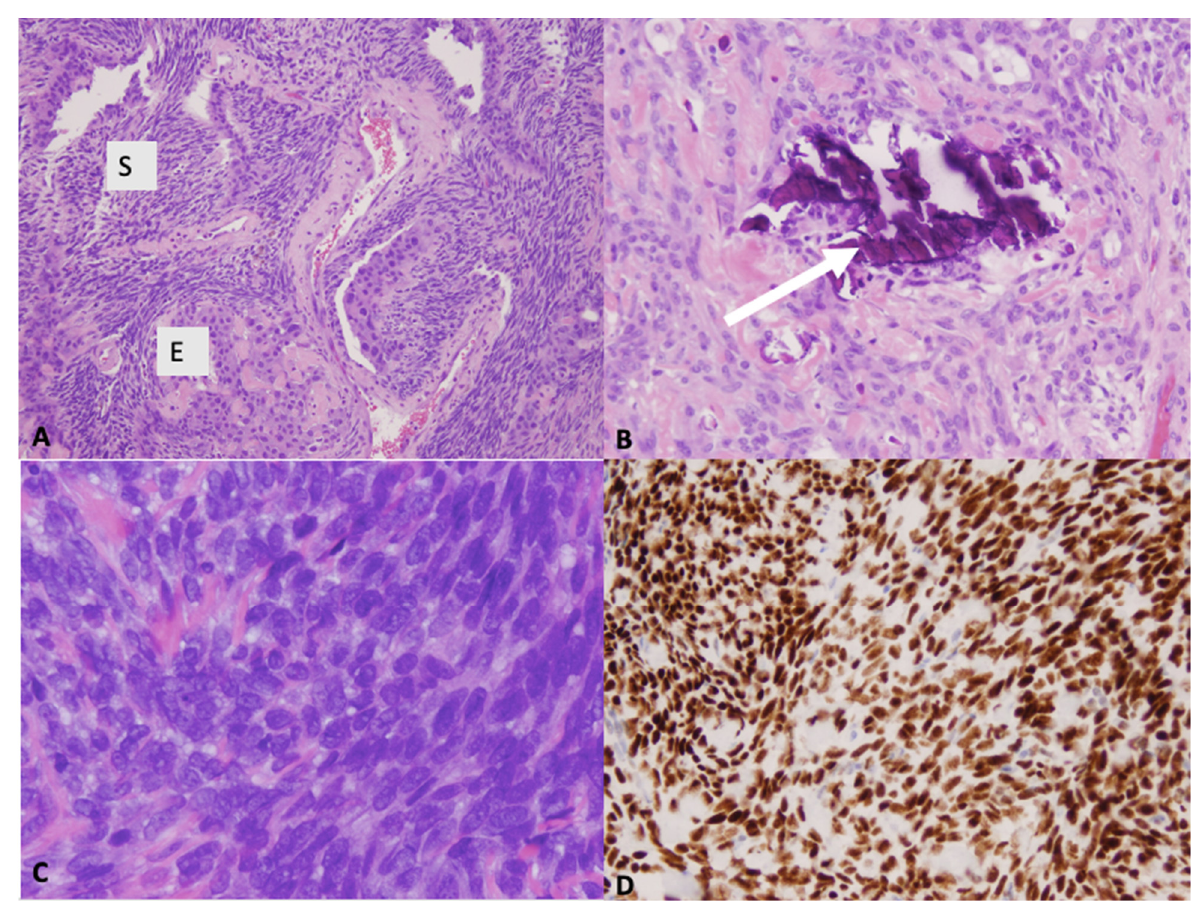
Figure 3. ( A ) Microscopic images showing biphasic tumor composed of spindle cell (S) and epithelioid (E) component; H&E ×100 and ( B ) occasional calcifications (arrow); H&E ×200). ( C ) Microscopic image showing poorly differentiated mor- phology (H&E ×400). ( D ) Immunohistochemistry demonstrating diffuse and strong nuclear staining for the transcriptional corepressor TLE1 (×200).